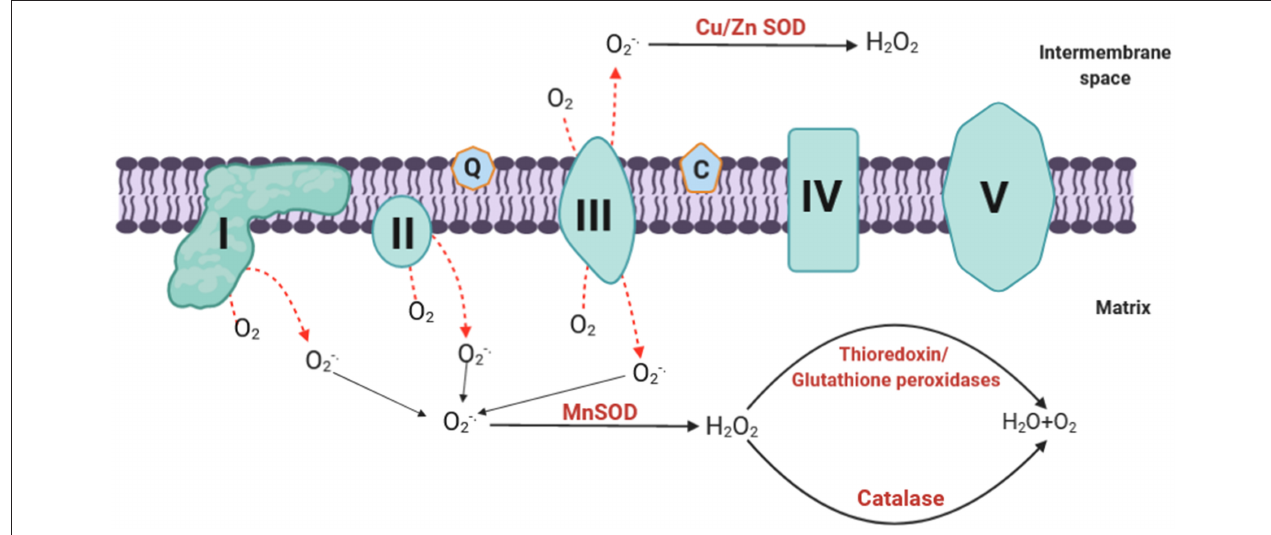
FIGURE 2 | mtROS elimination. The generated superoxide is dismutated to H 2 O 2 by Mn-SOD at the matrix or Cu/Zn SOD at the intermembrane space. The hydrogen peroxide formed can be degraded by catalase, thioredoxin, and glutathione peroxidases to form water. O − . 2 , superoxide; H 2 O 2 , hydrogen peroxide; SOD, superoxide dismutase; Mn, manganese; Cu, copper; Zn, zinc; H 2 O, water; O 2 , molecular oxygen; mtROS, mitochondrial reactive oxygen